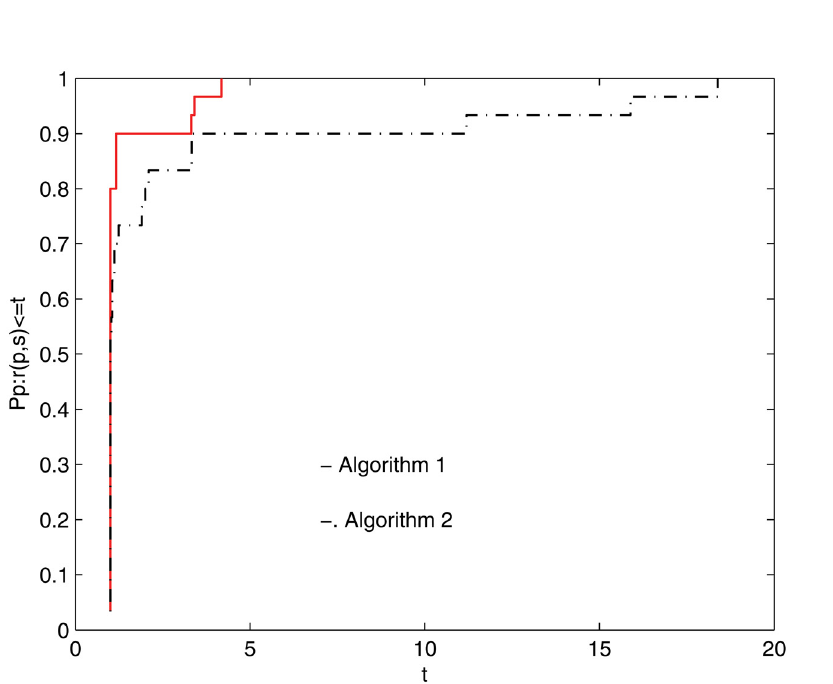
Fig 2. Performance profiles of these